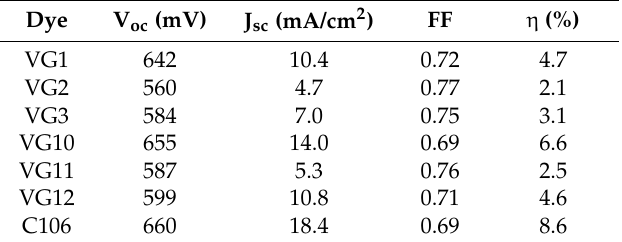
Table 1. J-V characteristics for VG2-C8, VG3-C8, VG11-C8, VG12-C8 sensitized solar cells measured under standard A.M. 1.5G illumination (100 mW/cm 2 ). The values are compared to the benchmark C106 ruthenium dye [2] and to VG1-C8 [10] and VG10-C8 [11] using the same electrolyte